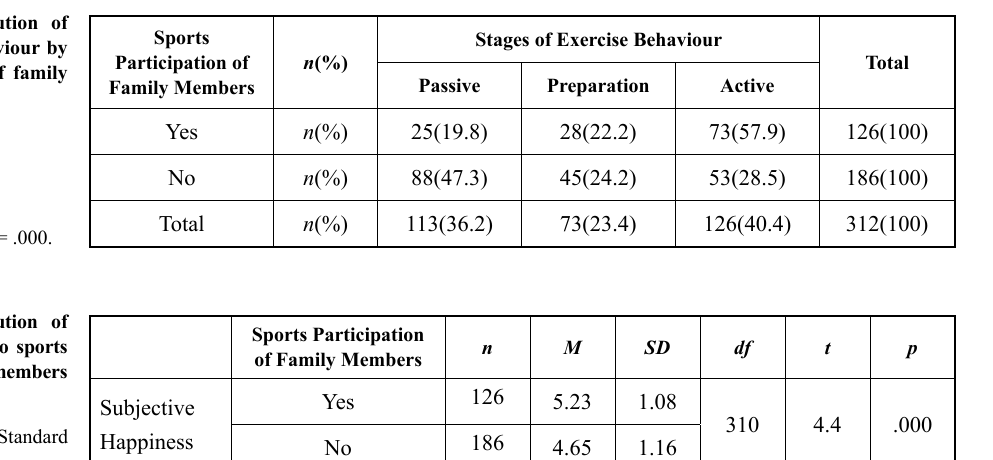
Table 5a. The distribution of stages of exercise behaviour by sports participation of family members